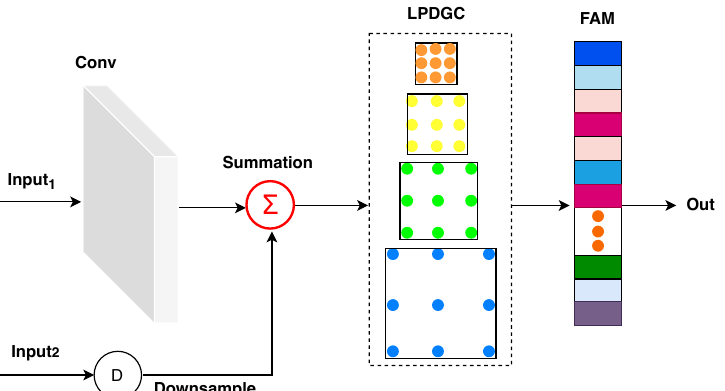
Figure 6. Proposed RFA module. Conv refers to convolution layers. D refers to the down-sampling rate. Out represents the output features generated by the RFA module. LPDGC refers to the learnable parallel dilated group convolutional block. FAM refers to the feature attention module.